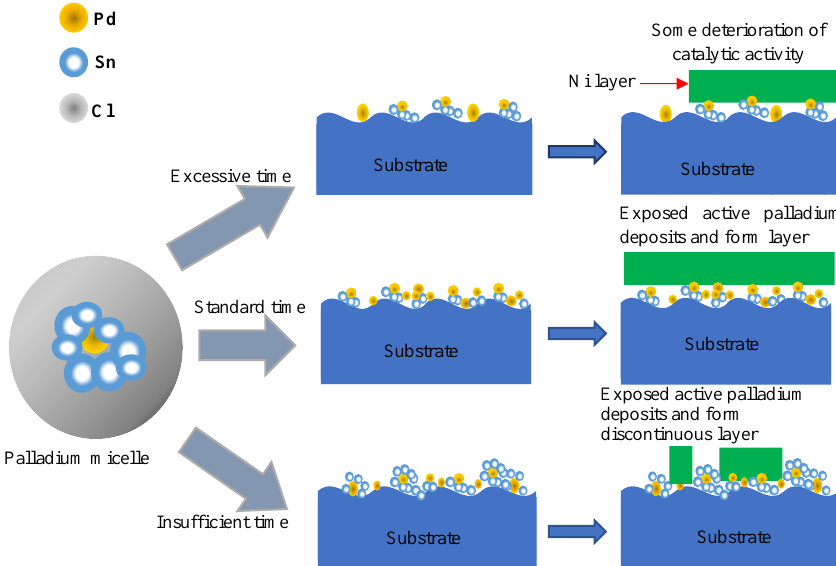
Figure 12. Illustration of acceleration of Pd micelle and formation of initial Ni layer.